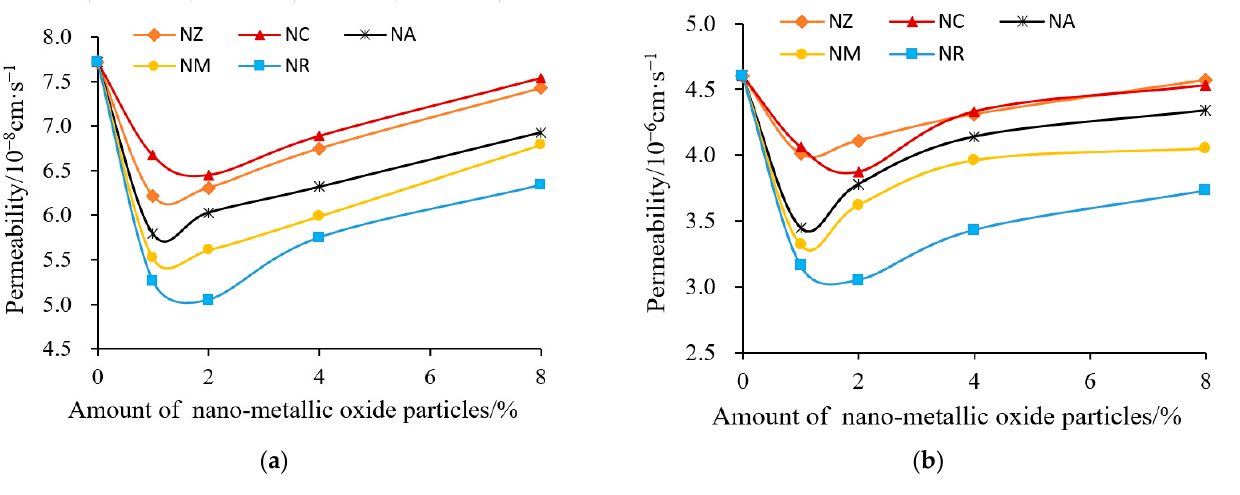
Figure 7. Permeability of cement mortar with nano-metallic oxide particles: (a) 28 days; (b) 730